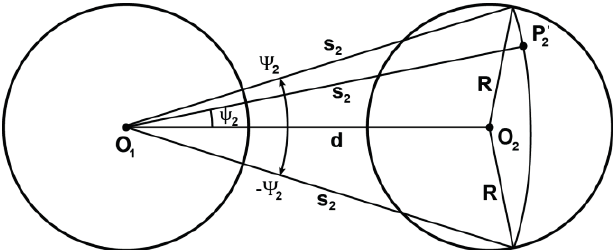
Figure 9: Polar coordinates ( ) for the projected inte- gration point . For constant , the angle varies between and . The coordinates of the point are now ( ) as shown in the projection in Fig. 10.